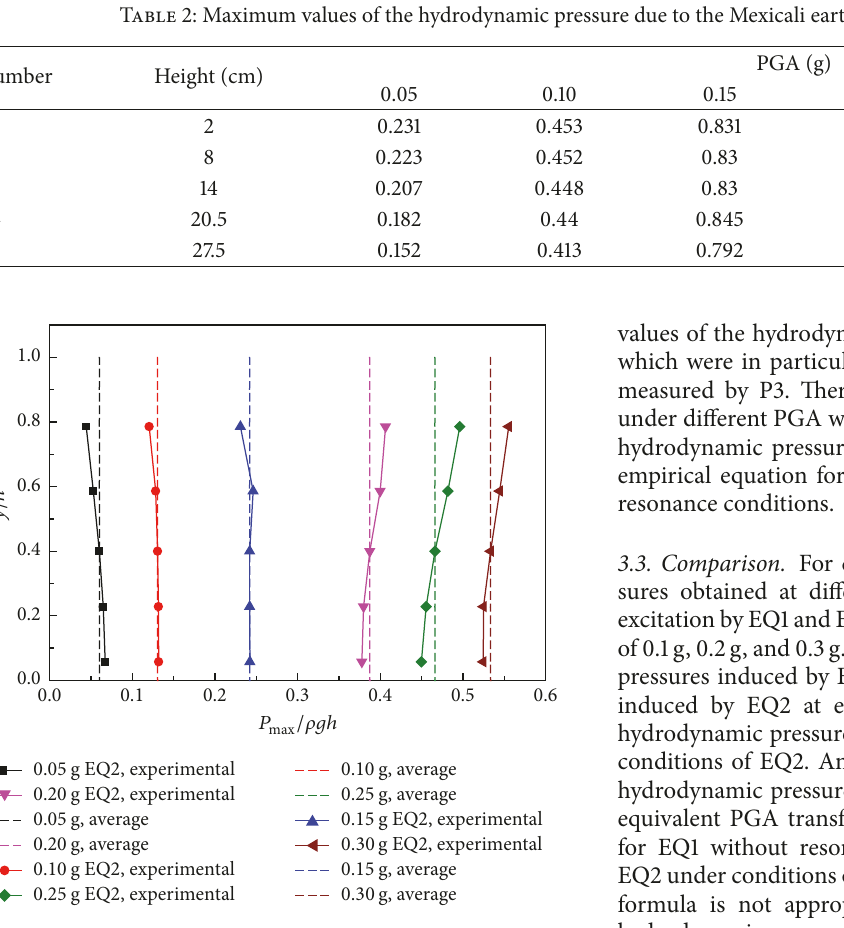
Figure 10: Distributions of the maximum hydrodynamic pressures acting on the wall at the vertical face due to the Mexicali earthquake waveform